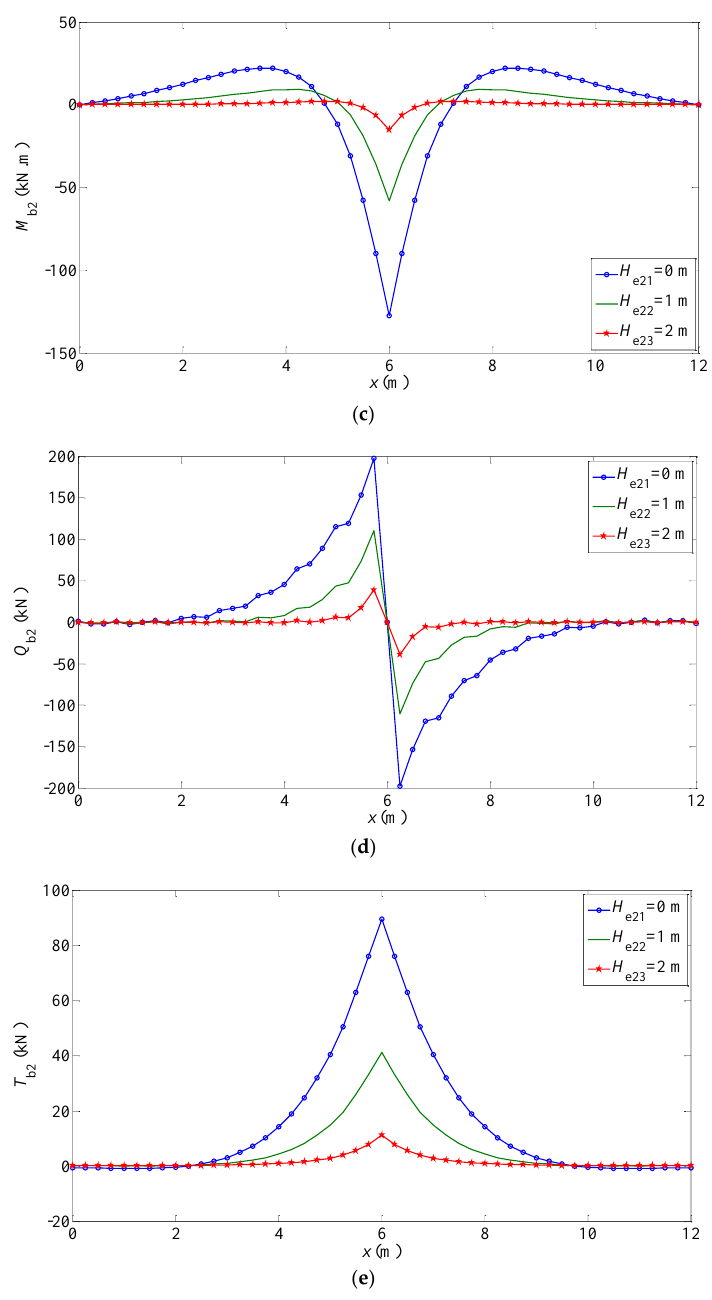
Figure 7. Results for of a beam embedded in a transversely isotropic foundation ( E T 21 = 28.8 MPa). ( a ) Displacement of a beam embedded in a transversely isotropic foundation ( E T 21 = 28.8 MPa); ( b ) rotation angle of a beam embedded in a transversely isotropic foundation ( E T 21 = 28.8 MPa); ( c ) bending moment of a beam embedded in a transversely isotropic foundation ( E T 21 = 28.8 MPa); ( d ) shear force of a beam embedded in a transversely isotropic foundation ( E T 21 = 28.8 MPa); ( e ) subgrade force of a transversely isotropic foundation ( E T 21 = 28.8